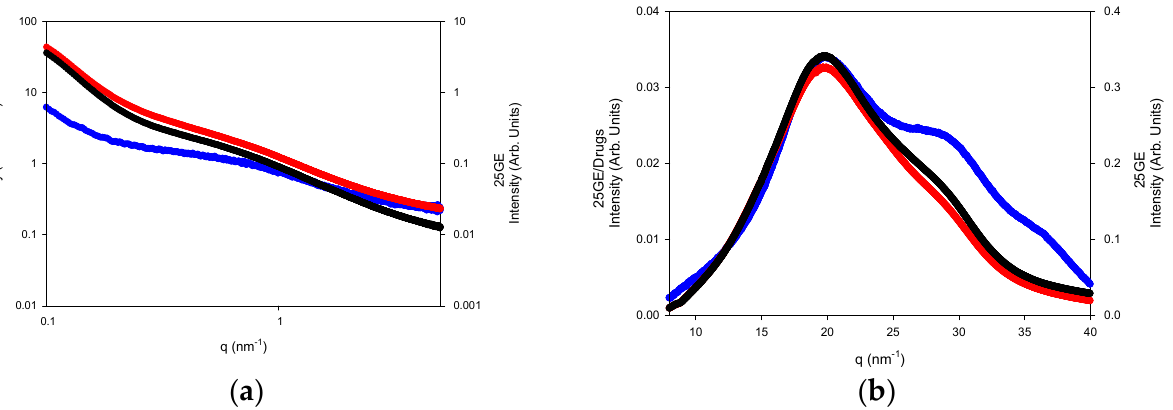
Figure 16. ( a ) Experimental SAXS profile as well as fitted together with the model contributions; ( b ) size distribution of the aggregates of the 25GE hydrogel. The WAXS profiles of the hydrogels reveal the diminishing of the amorphous region, likely due to its solubilization whilst remaining the refraction of the α -helices or the triple refraction that could indicate the renaturation of the single triple helix in good agreement with the FTIR spectra. Furthermore, the addition of drugs to the gelatin network (Figure 17a,b) slightly modifies the internal structure of the tuna hydrogel as shown by FTIR.